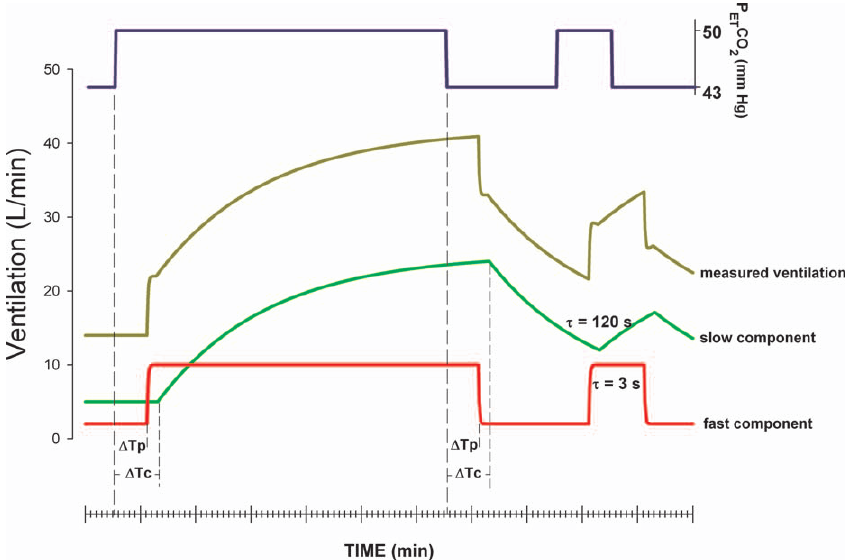
Figure 3. Separation of the Dynamic Ventilatory Response to P ET CO 2 P ET CO 2 is depicted in blue. Shown is separation of measured ventilation (dark yellow) into a fast component with a short delay ( D T P ) originating at the peripheral chemoreceptors (red, time constant of response 3 s), and a slow component with a long delay ( D T C ) originating at the central chemoreceptors (green, time constant of response 120 s). doi:10.1371/journal.pmed.0040239.g003 PLoS Medicine |